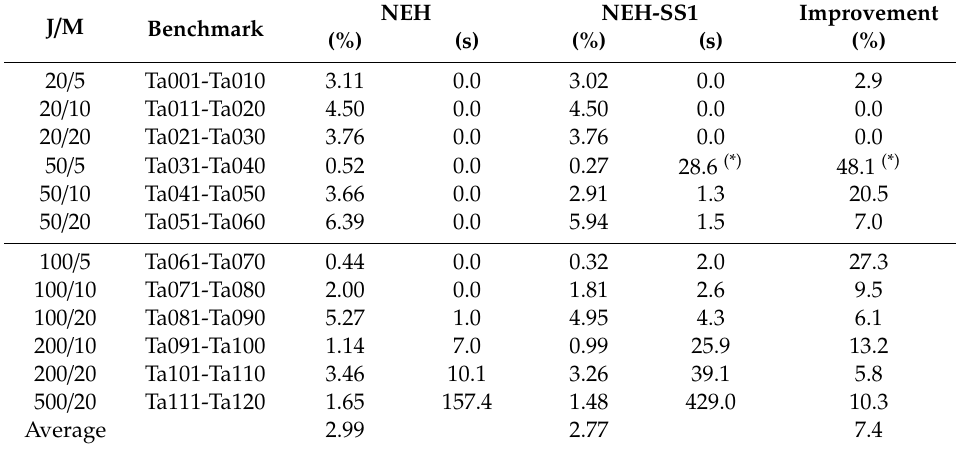
Table 3. NEH-SS1 improvement heuristic results (average relative percentage deviation (ARPD) in % and average CPU times in